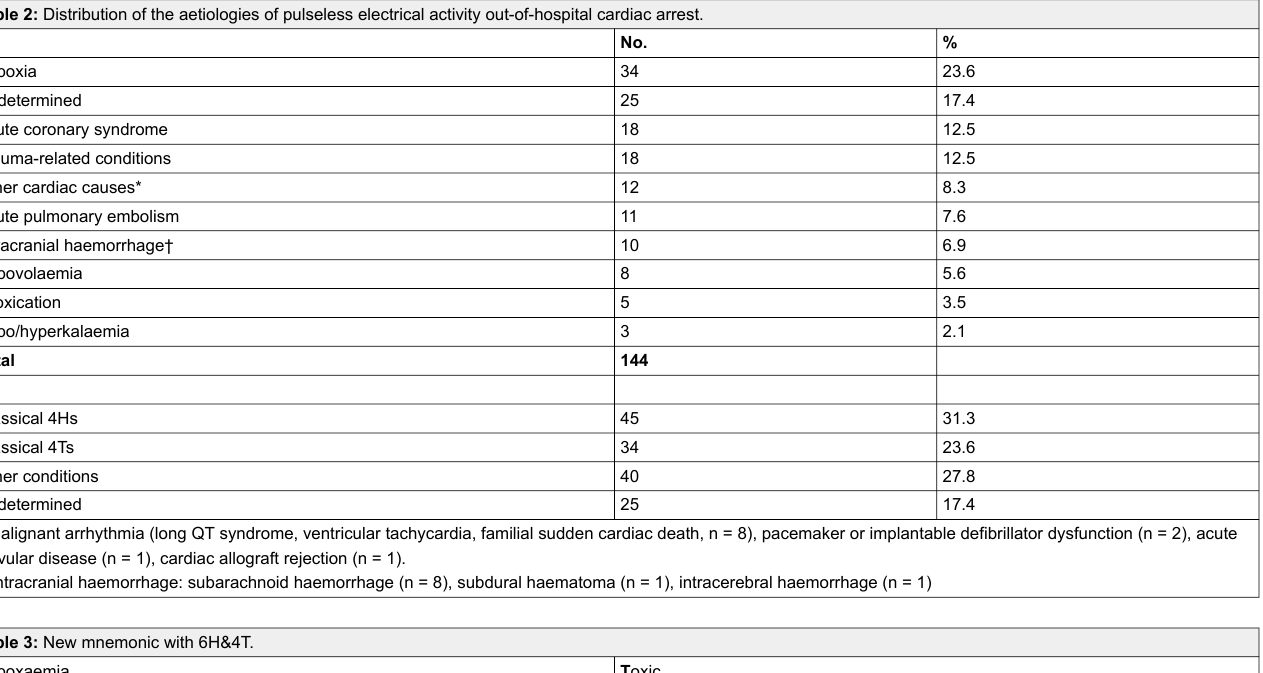
Table 2: Distribution of the aetiologies of pulseless electrical activity out-of-hospital cardiac arrest. Hypoxia